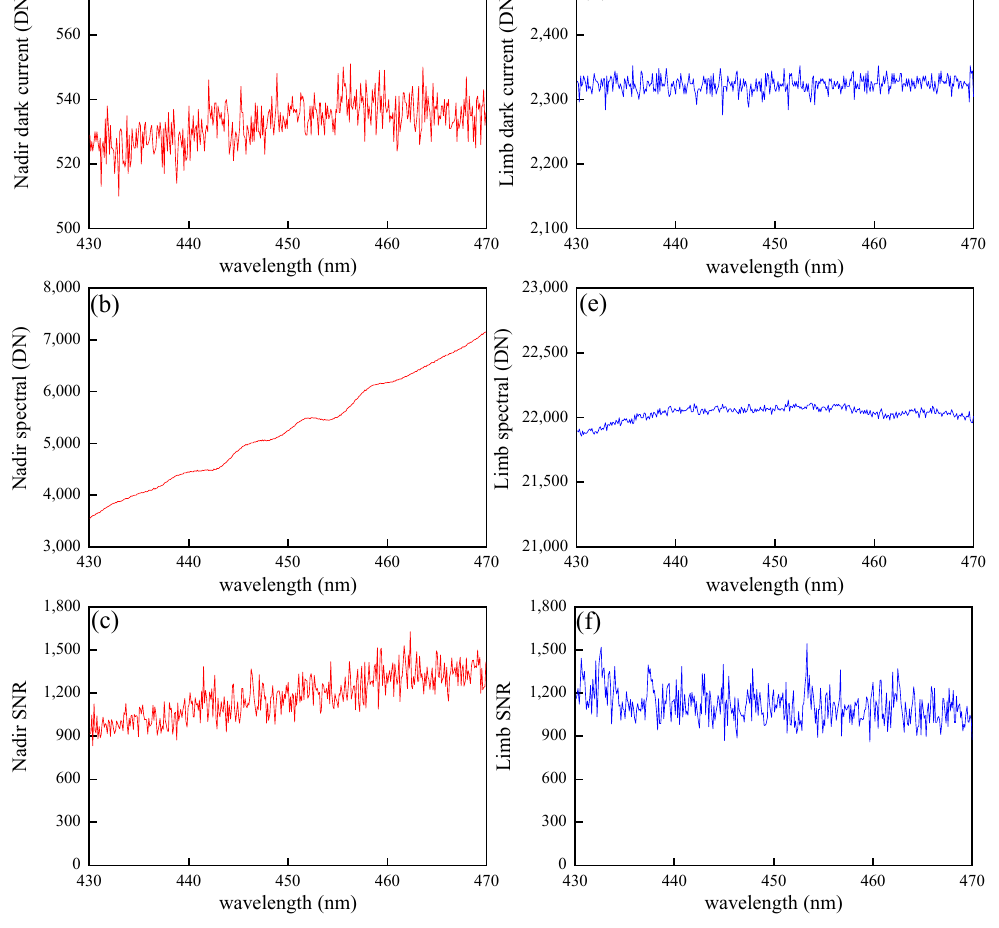
Figure 9. Ground-based measured: ( a ) dark current; ( b ) spectral; ( c ) SNR of the 92nd pixel of the VIS1 channel of the nadir module in the range of 430–470 nm; ( d ) dark current; ( e ) spectral; and ( f ) SNR of the 125th pixel of the UV2 channel of the limb module in the range of 430–470 nm.